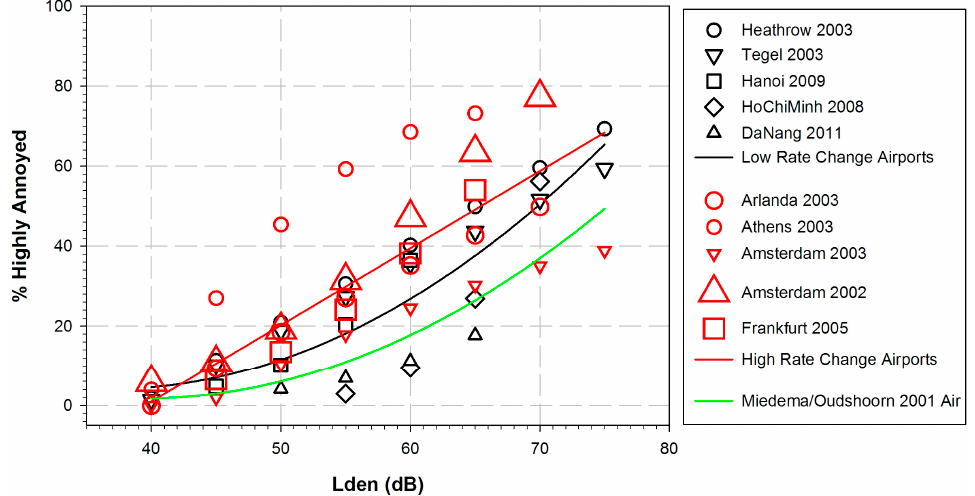
Figure 3. Scatterplot and regression lines of the relation between L den and the calculated %HA for five “high ‐ rate change” (red curve) and five “low ‐ rate change” (black curve) airport noise studies, together with exposure ‐ response function by Miedema and Oudshoorn ([4], green curve). Notes: (1) The size of the data points corresponds to the number of participants in the respective study (size = SQRT(N)/10). (2) If two results from different studies fall on the same data point, the last point plotted masks the former one. (3) The red and black curves are derived from aggregated secondary data, while the green curve is derived from individual data. In addition, the mathematical models used for establishing the three functions differ.